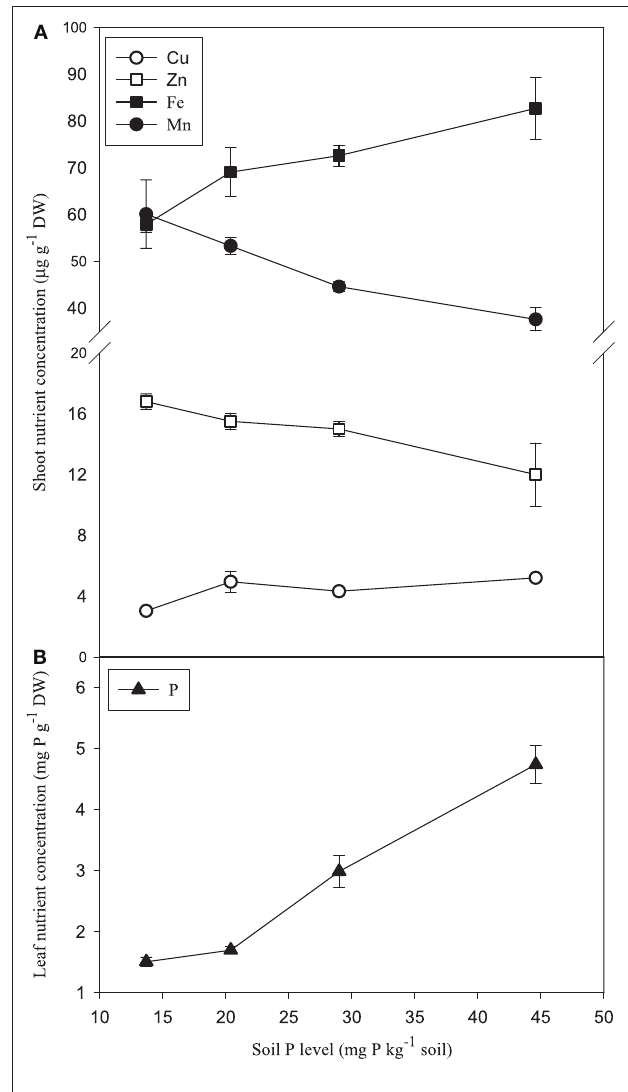
FIgure 8 | Leaf concentrations of Mn, Zn, Fe, Cu (A), and P (B) in plants of the Mn-inefficient genotype Antonia growing in soil with increasing P levels. Values are means ± SE ( n